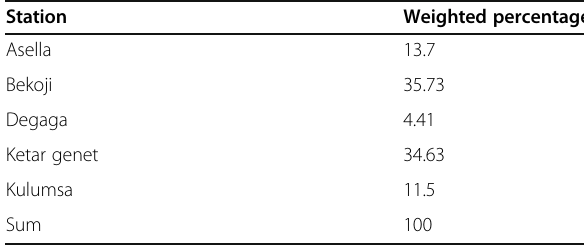
Table 1 Precipitation percentage weight of stations by Thiessen polygon method in the Ketar